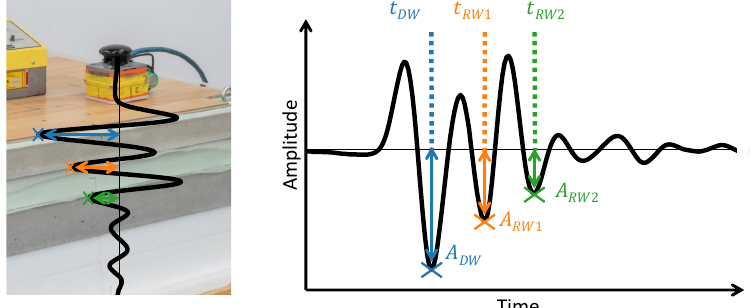
Figure 7. Exemplary A-scan with three prominent amplitudes influenced by present material